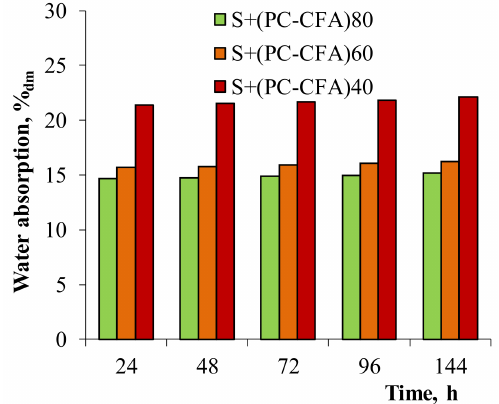
Figure 6. Water absorption capacity of solidified